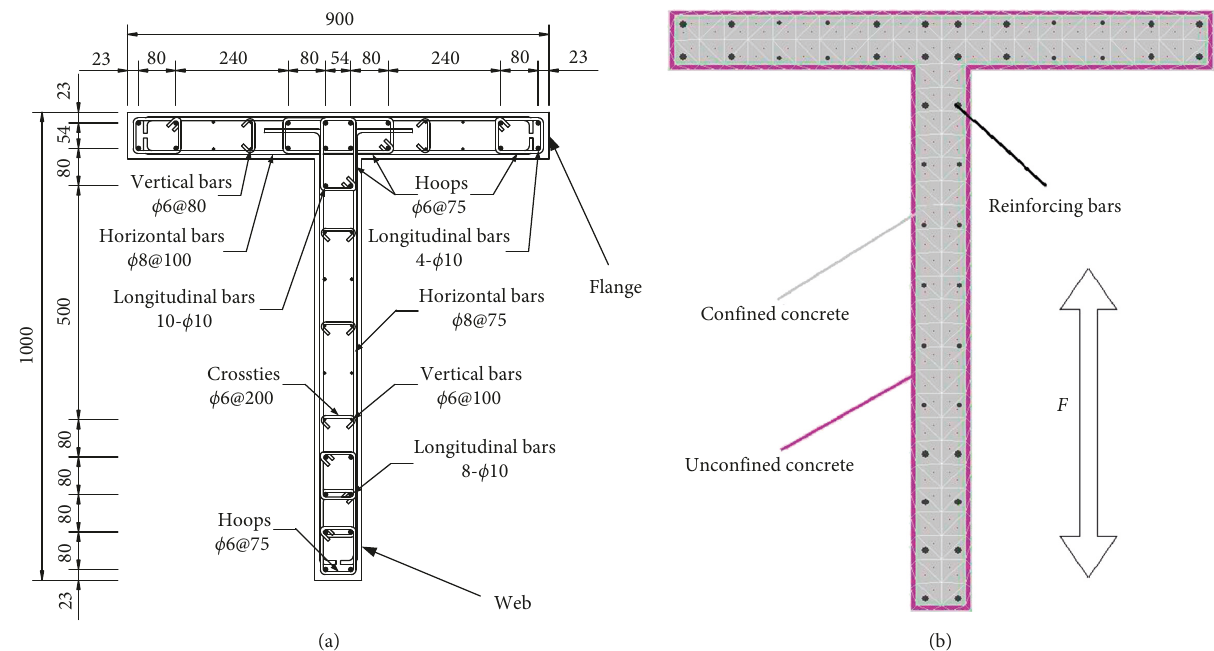
Figure 1: Prototype wall for numerical analysis. (a) Detail dimensions and reinforcement. (b) Finite element model.